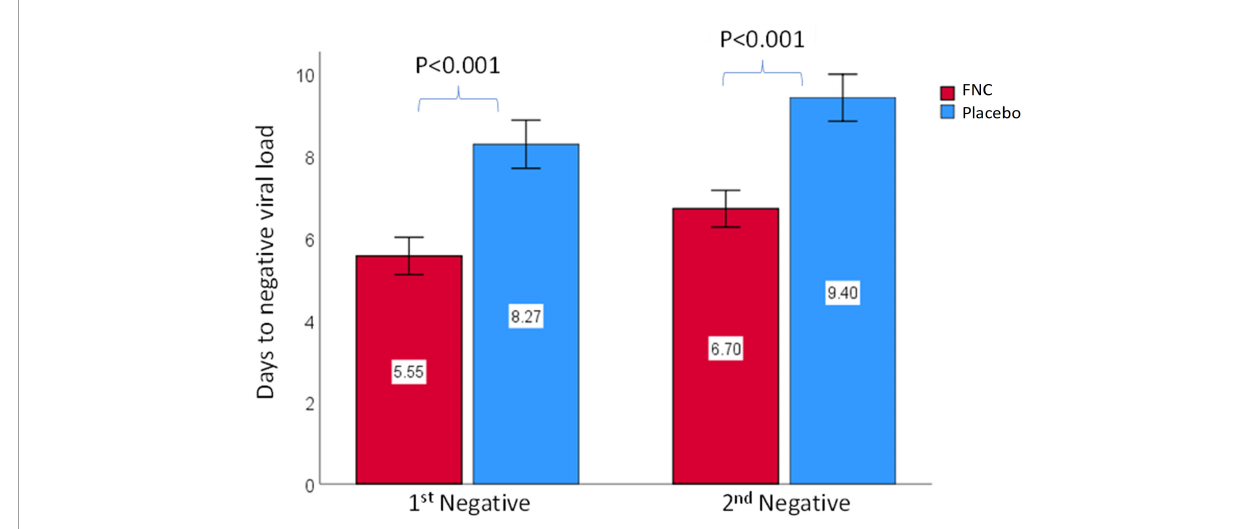
FIGURE2 Comparison of the time of the first and the second nucleic acid testing negativity between all subjects in the FNC group and the placebo group. Data are mean (SD). The differences between groups were analyzed using Mann–Whitney test.